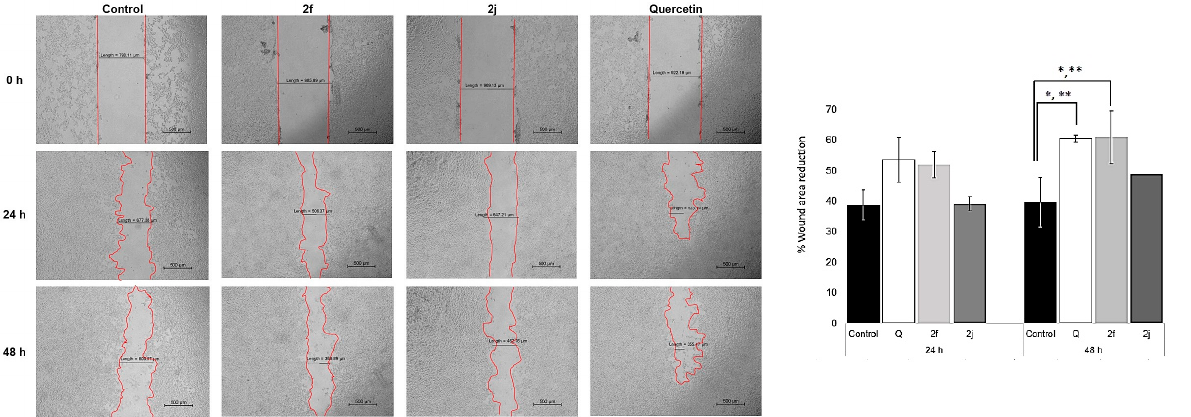
Figure 7. A scratch assay was performed to examine the migration ability of synthesized compounds 2f and 2j at 100 µM compared with untreated control. Representative pictures of the assay induce the migration of HEK cells using quercetin as a reference. Pictures were taken at the start of the experiment (0 h) 24 and 48 h later. Pictures of representative experiments are shown, and the relative migration of cells is represented with a bar graph; means ± SD ( n = 3; *: p < 0.05 and **: p < 0.001, Turkey HSD), Scale bars represent 500 µm.